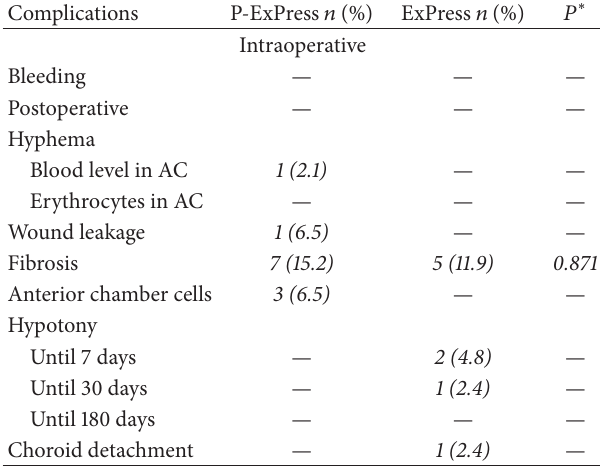
Figure 1: Cumulative surviving proportion (Kaplan-Meier) for success criterion of intraocular pressure less than or equal to 18mmHg. Without medications, complete success rate.